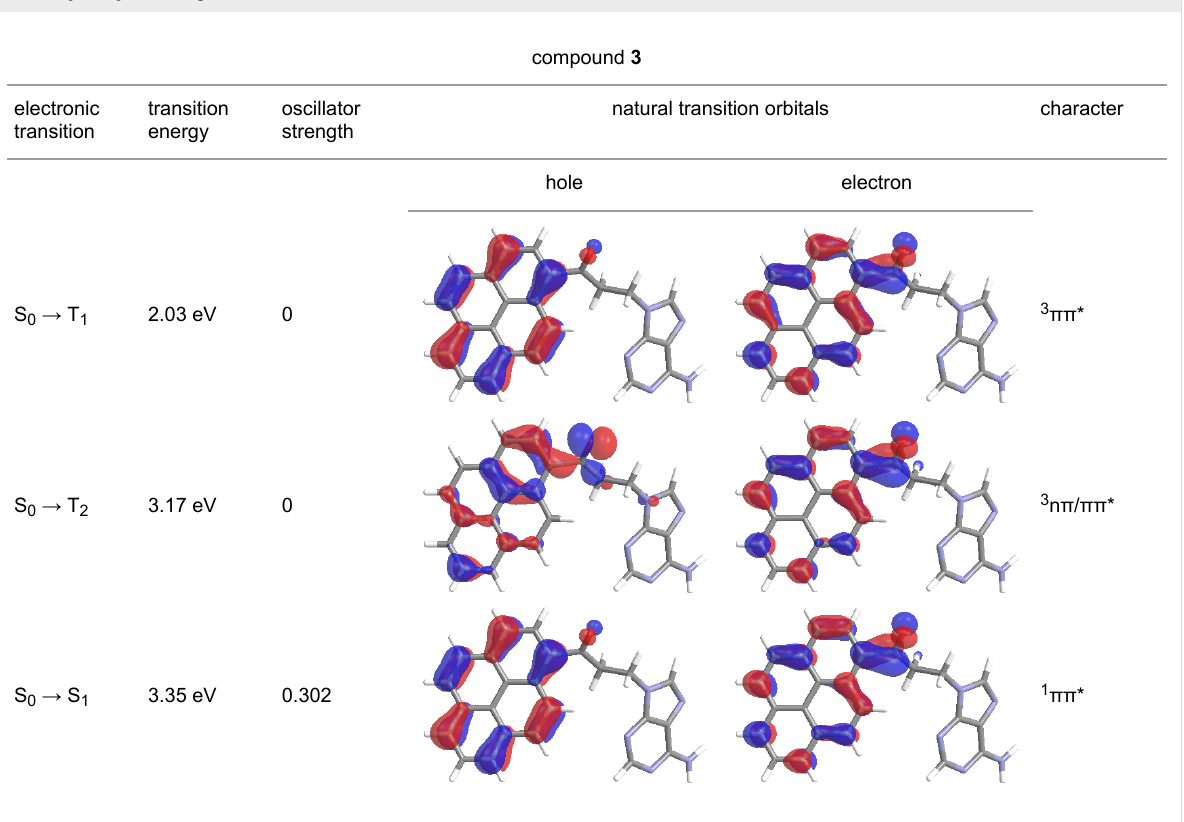
Table 2: Selected lowest-energy vertical electronic transitions resulting from TD-DFT calculations for pyrene–adenine conjugates 3 and 5 in the ground state geometry at the B3LYP/6-311G(d,p) theory level. “Holes” (starting orbitals) and “electrons” (final orbitals) represent natural transition orbitals [32,33] describing each excited